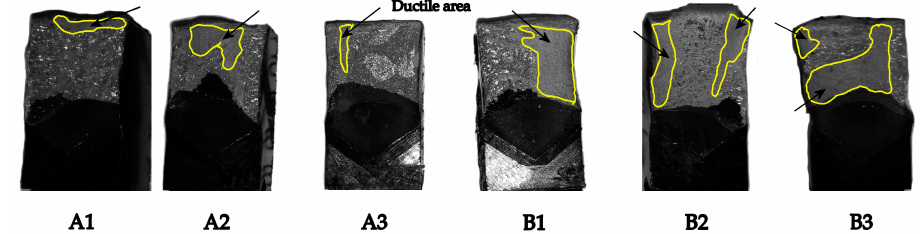
Figure 9. Overview of three-point bend fracture surfaces. Table 4. Fracture energy of each joint zone.